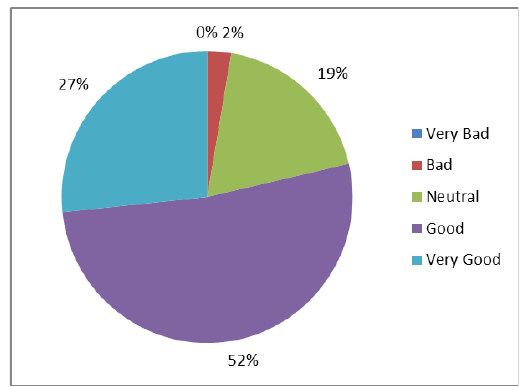
Fig. 1. Overall experience with